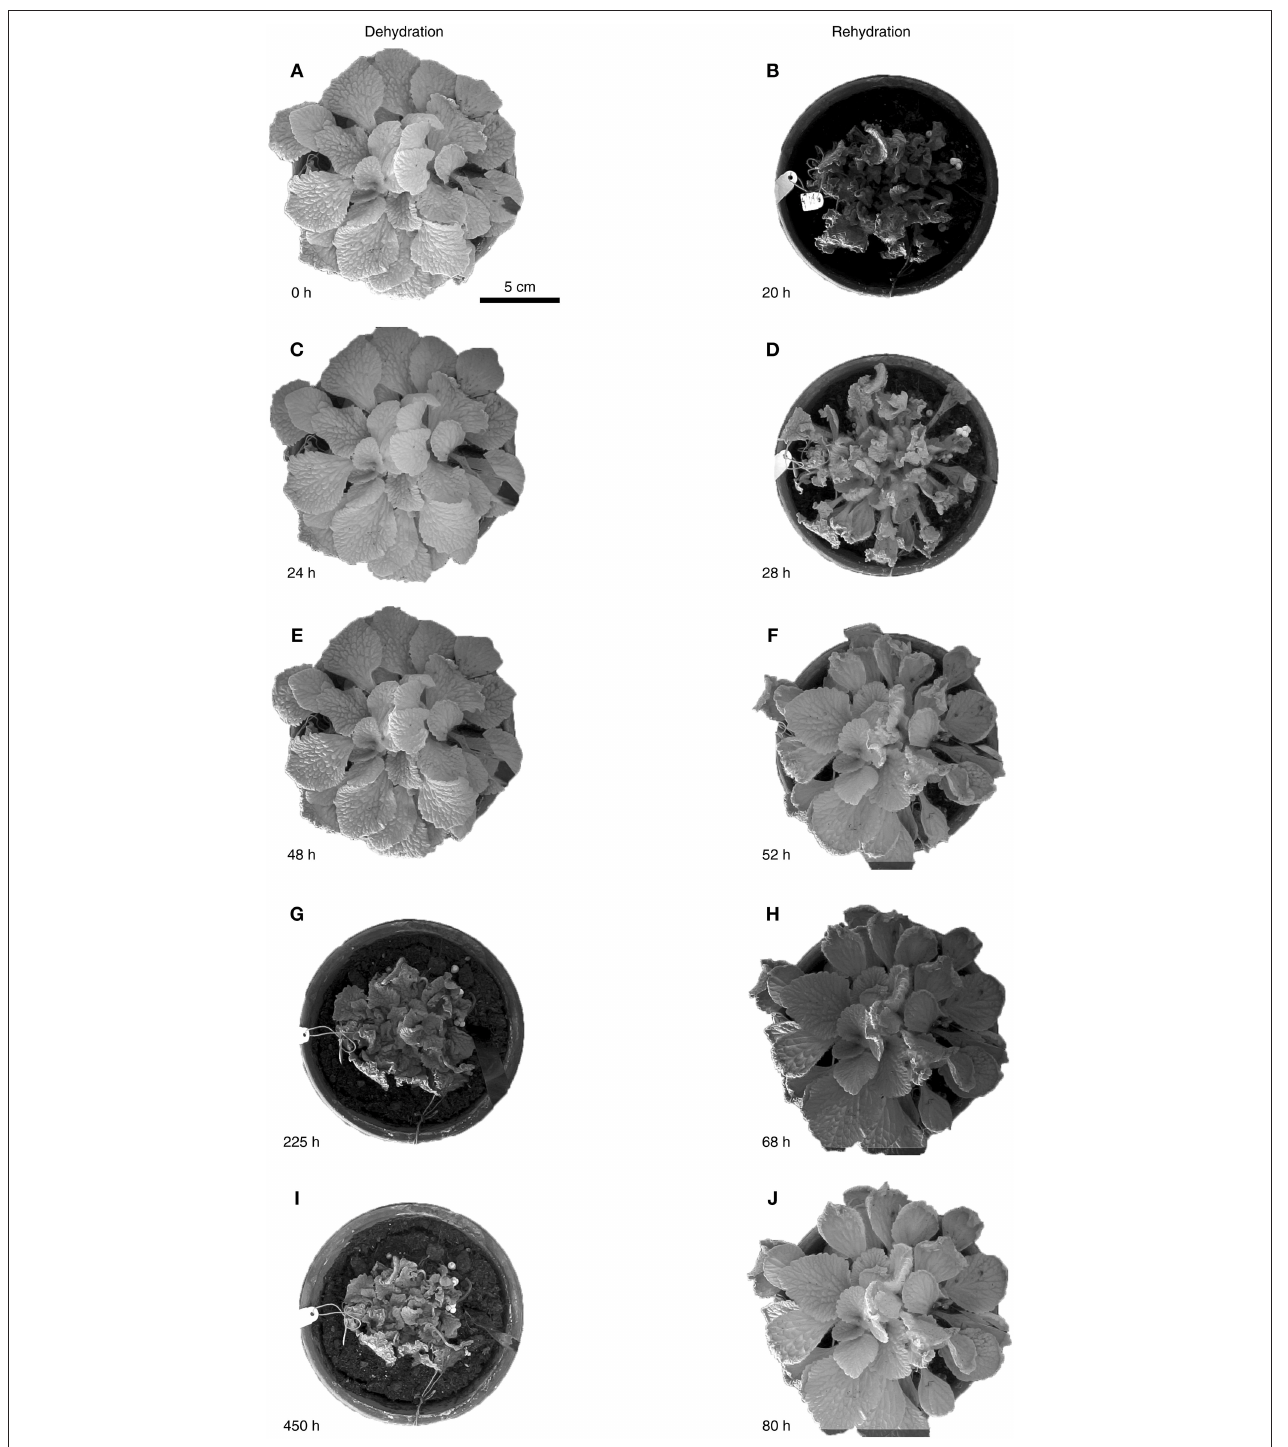
FIGURE 2 | Water status dependent folding kinematics of R. myconi . Folding and shrinking of R. myconi plants at 0h (A) , after 24h (C) , 48h (E) , 225h (G), and 450h (I) of dehydration. Unfolding and swelling of R. myconi plants after 20h (B) , 28h (D) , 52h (F) , 68h (H), and 80h (J) of rehydration. R. myconi is able to withstand severe drought stress and re-establishes its normal shape upon rehydration. For reasons of simplification the graph depicts the results of one representative experiment.